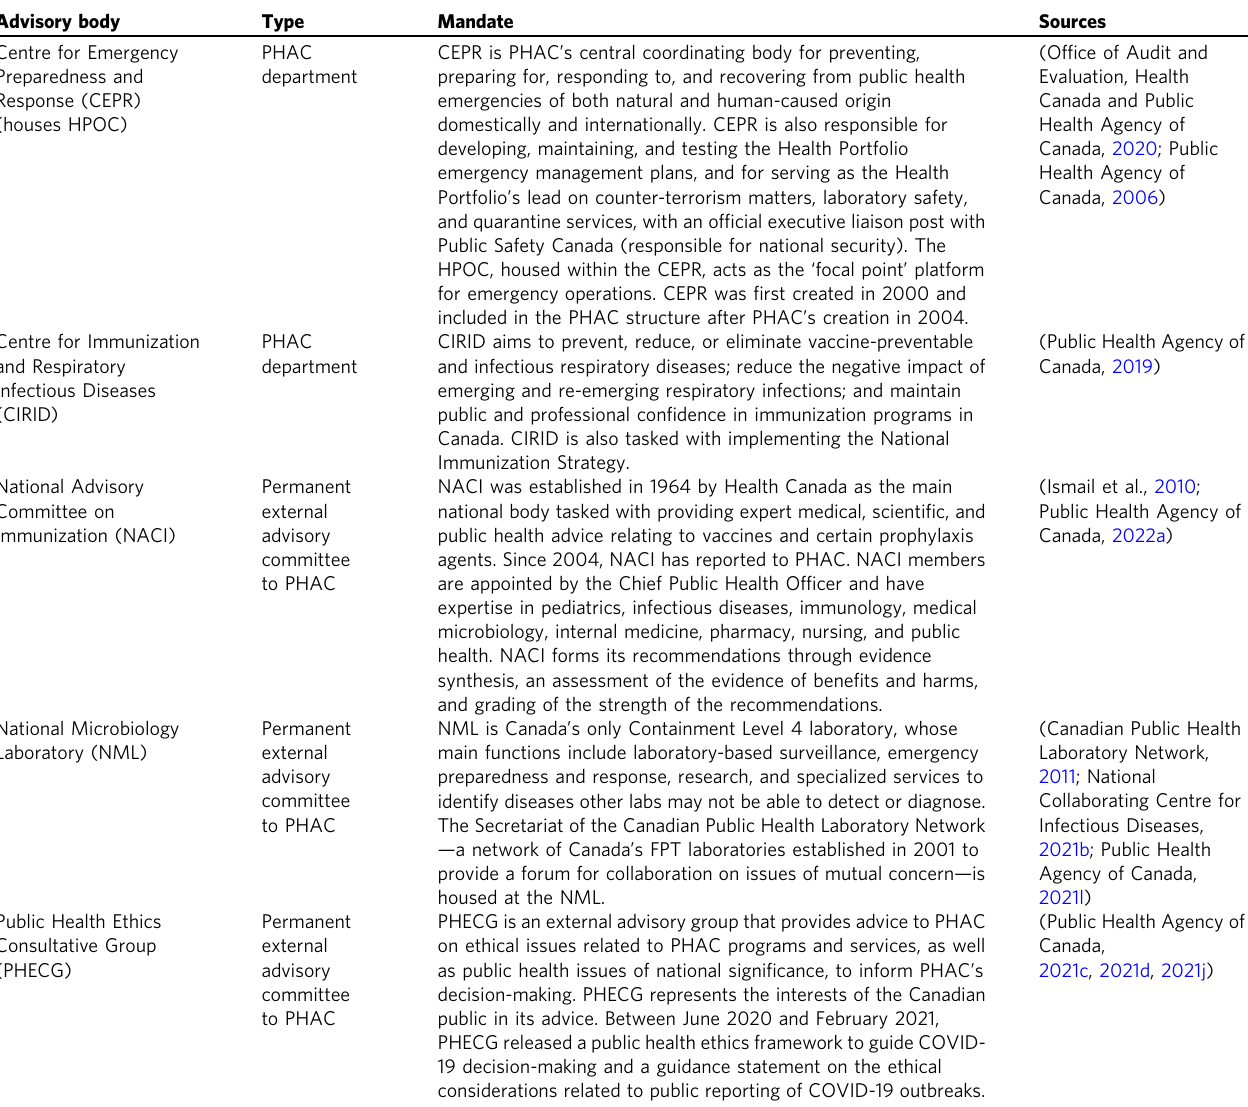
Table 1 Public Health Agency of Canada (PHAC) programs of